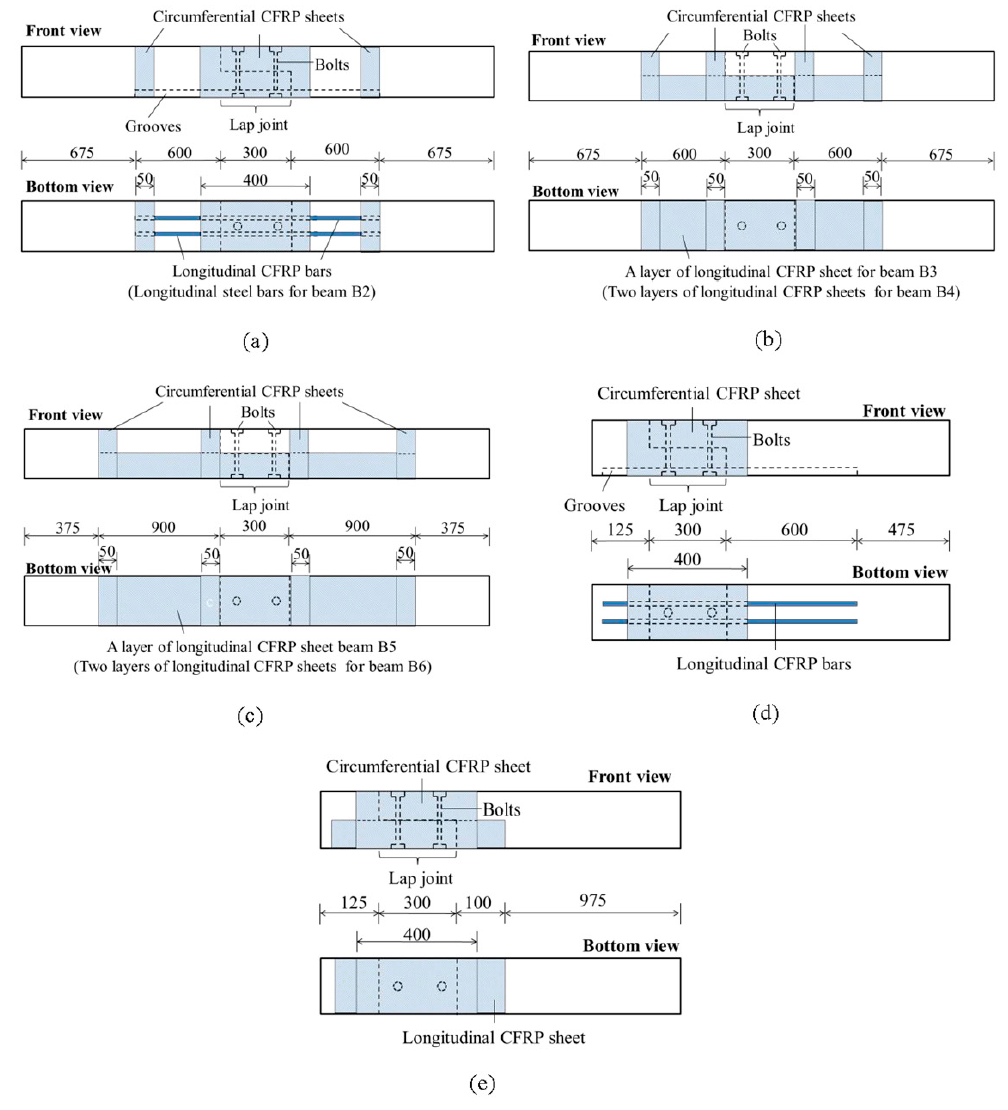
Figure 3. Schematic diagrams of the strengthening methods (in millimeters). ( a ) Beams B1 and B2; ( b ) beams B3 and B4; ( c ) beams B5 and B6; ( d ) beam S1; ( e ) beam S2.